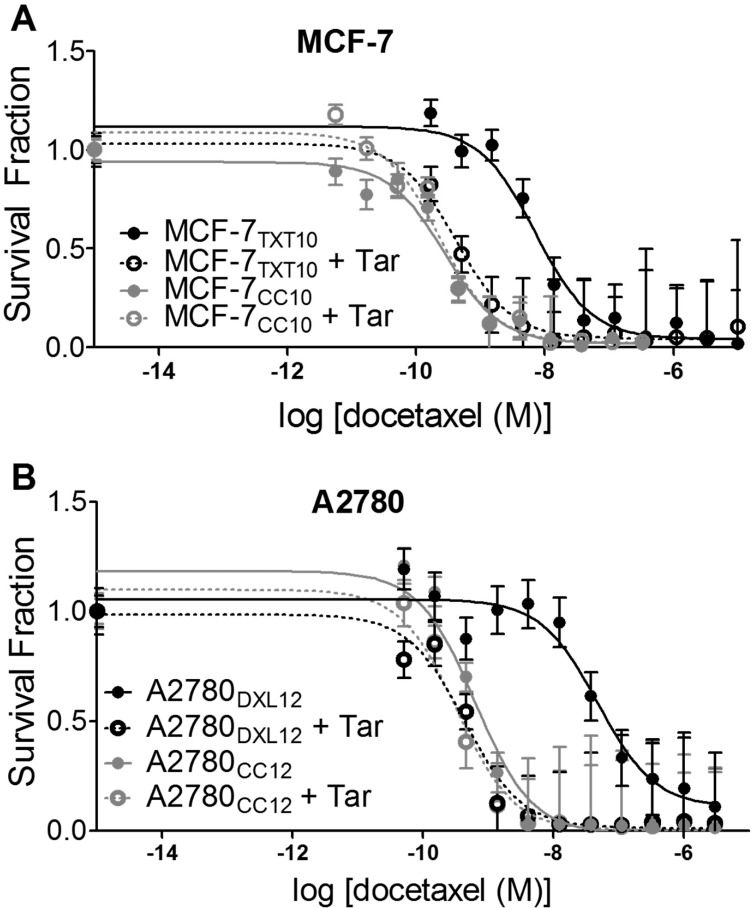
Sensitivity to docetaxel is restored upon inhibition of P-gp activity with Tariquidar (Tar).(A) Clonogenic assays yielded IC50 values for docetaxel in MCF-7CC10 cells of 0.28 nM and 0.24 nM, with and without 100 nM Tariquidar, respectively. IC50 values for MCF-7TXT10 cells were significantly different with (0.42 nM) and without (7.14 nM) Tariquidar, respectively (p<0.0001). (B) An identical trend was observed for the A2780CC12 (IC50 = 0.630 nM) and A2780DXL12 (IC50 = 47.5 nM) cell lines, where in the presence of Tariquidar IC50 values were 0.331 nM and 0.435 nM, respectively. Each data point represents the mean number of colonies (+/-SEM) in twelve independent microscopic fields. Each experiment was replicated three times with consistent trends. Non-linear regression analysis was used to compare the significance of difference in IC50 values between Tariquidar-treated and untreated conditions.